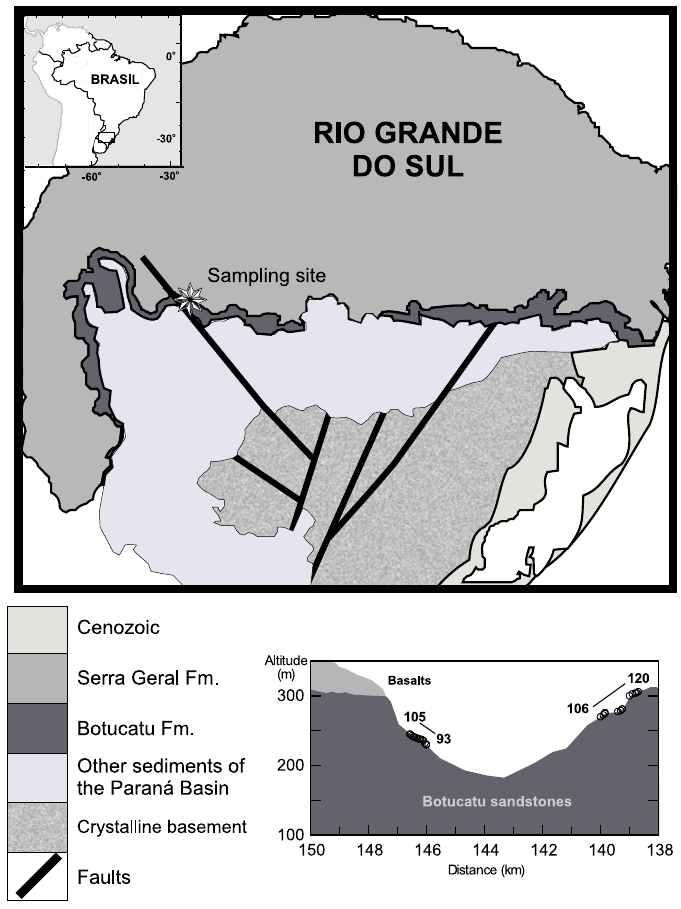
Fig. 1 – Simplified geological map showing the Botucatu exposure area in the Rio Grande do Sul State, based on E.L. Lavina (unpublished data). The smaller box shows section from where oriented samples were